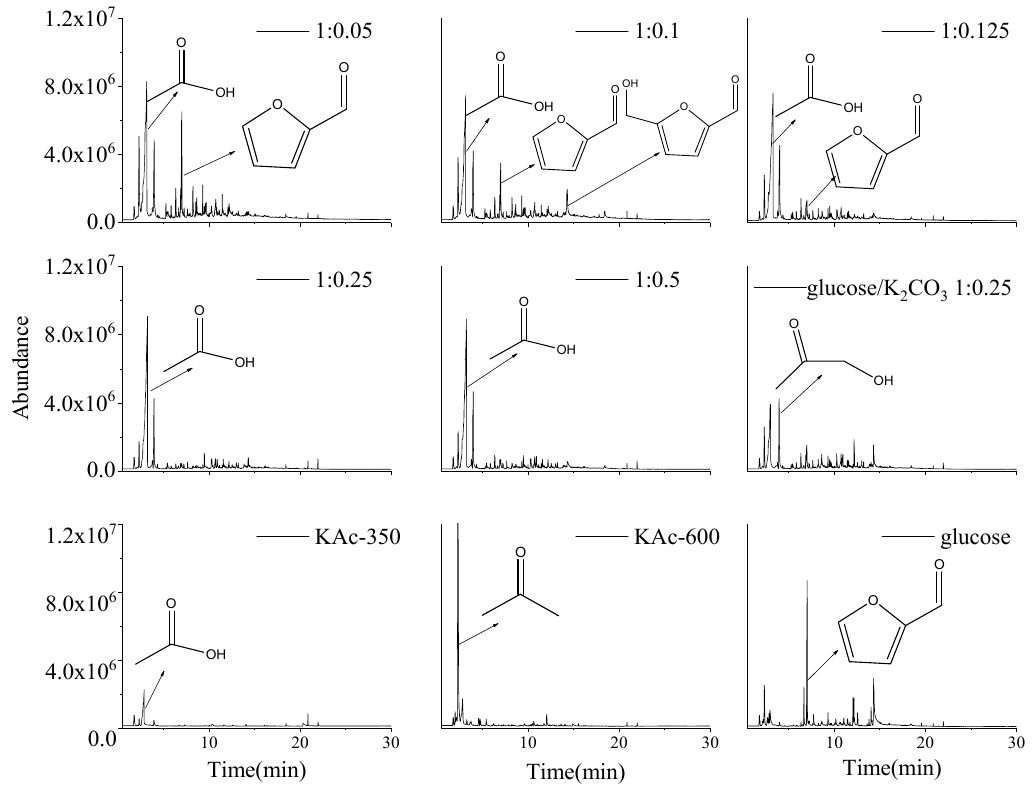
Figure 4. Pyrolysis coupled with gas chromatography and mass spectrometry (Py-GC/MS) total ion chromatograms of glucose, the glucose/KAc mixtures with different ratios (1:0.05, 1:0.1, 1:0.125, 1:0.25,1:0.5), the glucose/K 2 CO 3 mixtures (1:0.25) at 350 °C, and KAc at 350 °C and 600 °C.